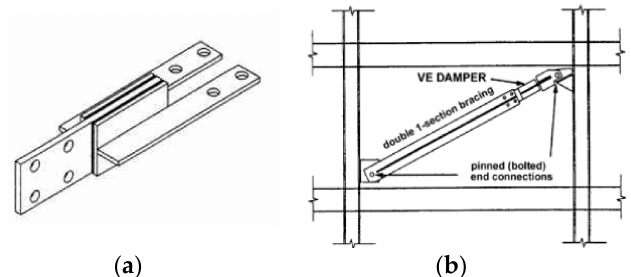
Figure 14. Longitudinal section of a typical Viscous fluid damper: ( a ) description of VDs, ( b ) one story frame with VDs.